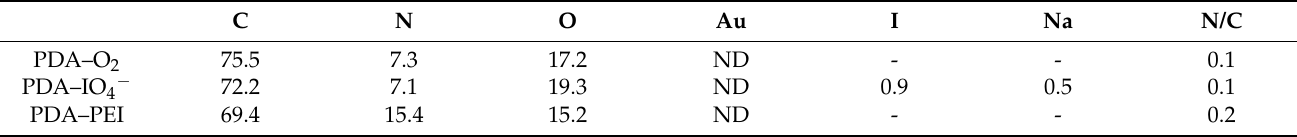
Figure 3. XPS survey spectra of gold surface coated with ( a ) PDA–O 2 , ( b ) PDA–IO 4 − and ( c ) PDA–PEI. Table 1. Atomic percentages and N/C ratio obtained from XPS data.